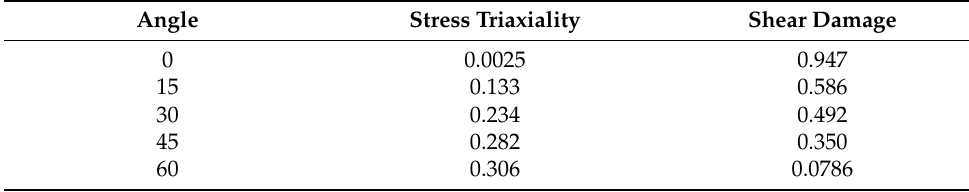
Table 8. Stress triaxiality and shear damage values at 673 K.